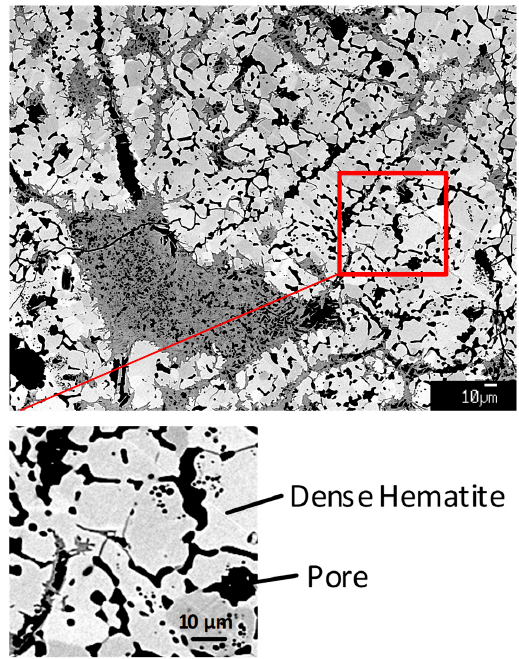
19 of 27 Figure 21. Magnetite and associated microstructures observed from magnetite formed at 1400 °C in air (94.33 wt % Fe 2 O 3 and a CaO/SiO 2 ratio of 5.32 wt/wt) (M—Magnetite) (BSE Micrograph). Reheating of this magnetite in air at 1200 °C resulted in the complete oxidation of the magnetite